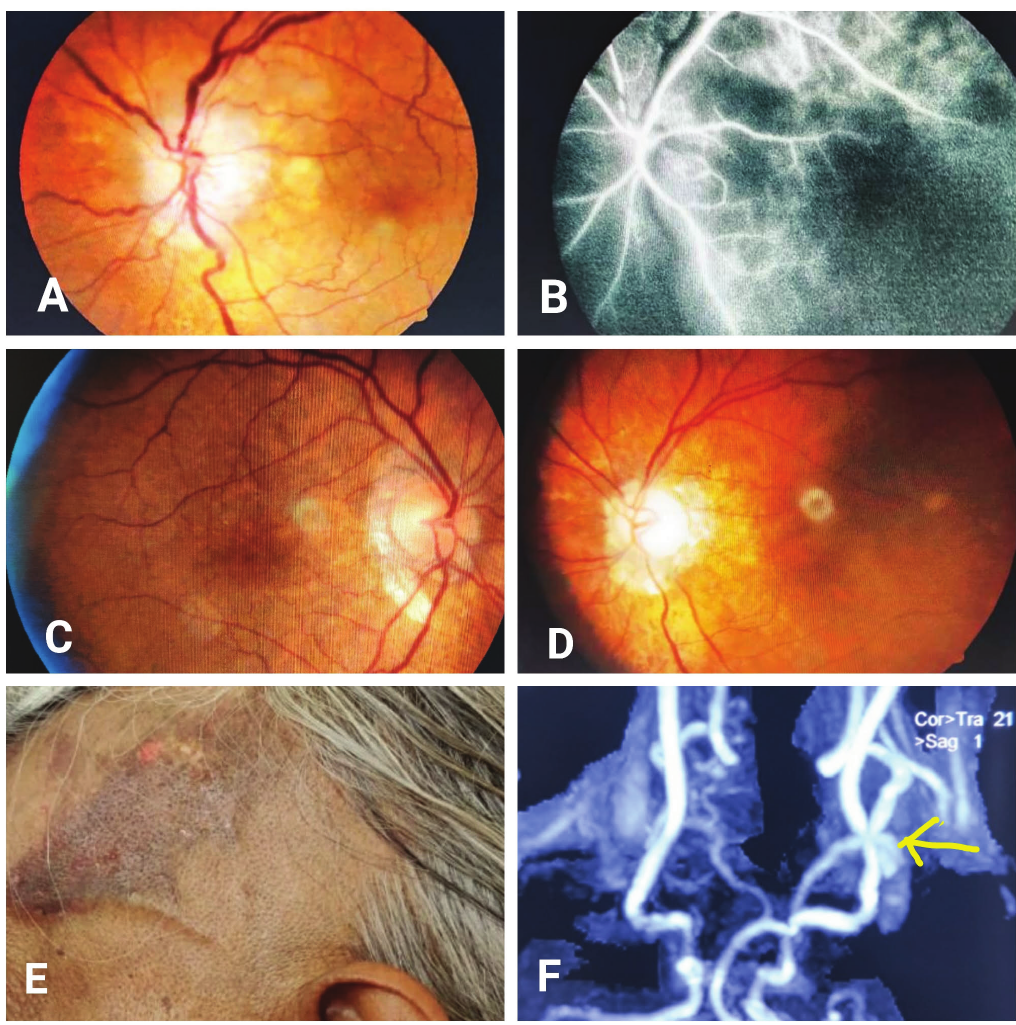
Figure 1. Pale disc edema with venous dilatation at presentation (A). FFA revealed choroidal ischemia with delayed AV transit (B). Right eye was normal (C). Optic disc pallor after 45 days of presentation (D). Left temporal scalp showed purpuric lesion with prominent temporal artery that was biopsied (E). MRA demonstrated ICA narrowing